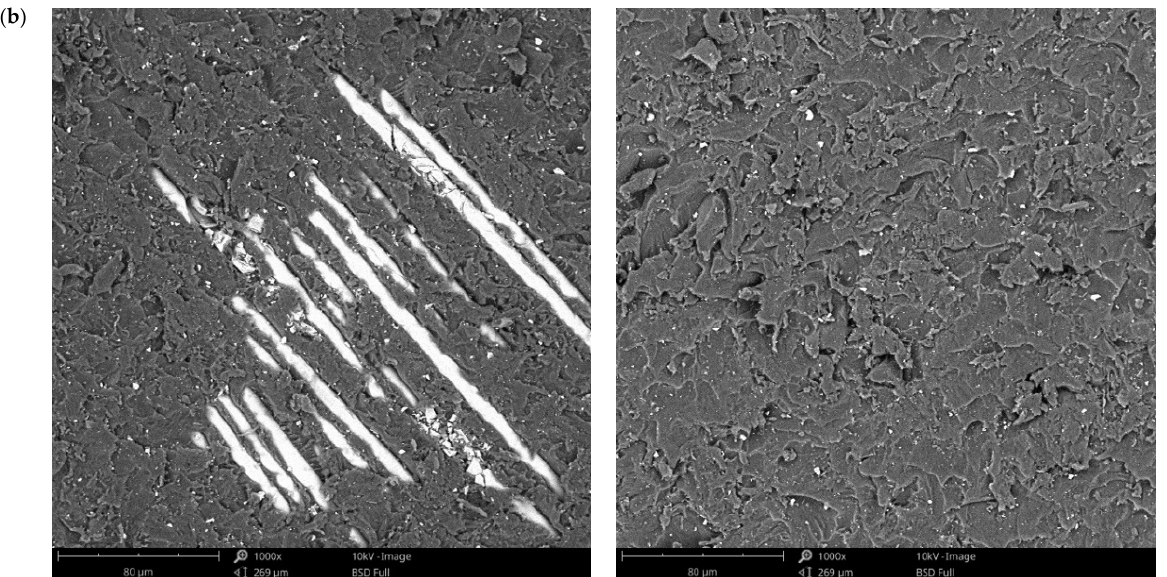
Figure 6. SEM images of the C1 sample surface after immersion tests at ( a ) 3 days and ( b ) 21 days in artificial saliva with pH 5.7 (1000×).